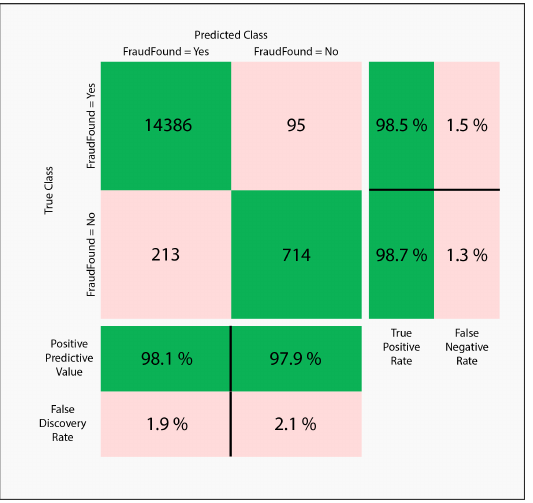
Figure 16. Confusion matrix of the proposed Bagged ensemble learning based model.